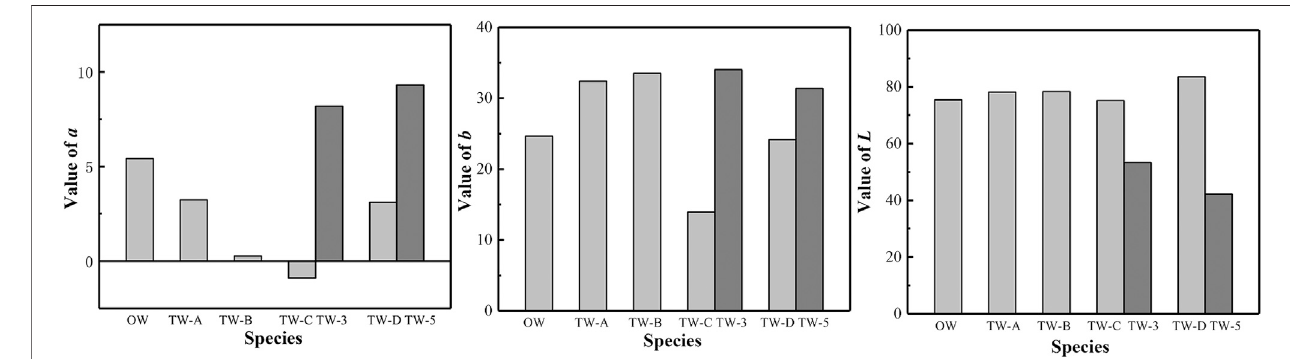
FIGURE 11 | L*a*b values of logs and transparent samples.